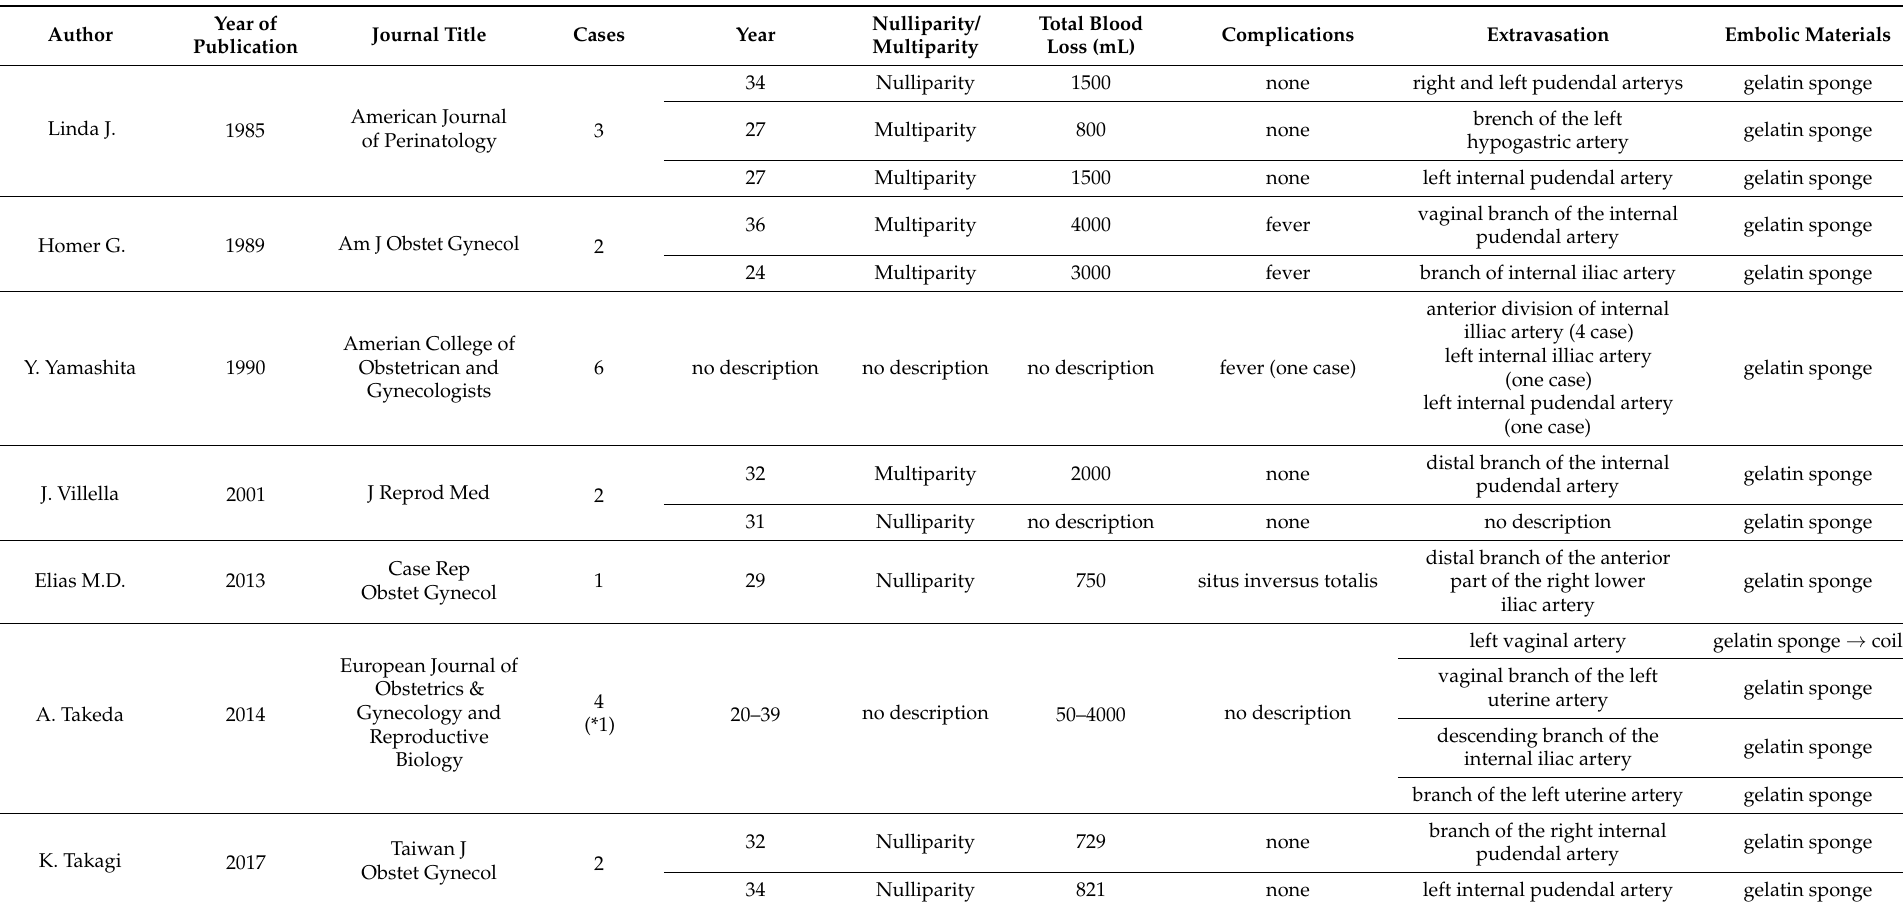
Table 2. Reviews of vulvovaginal hematoma treated by TAE